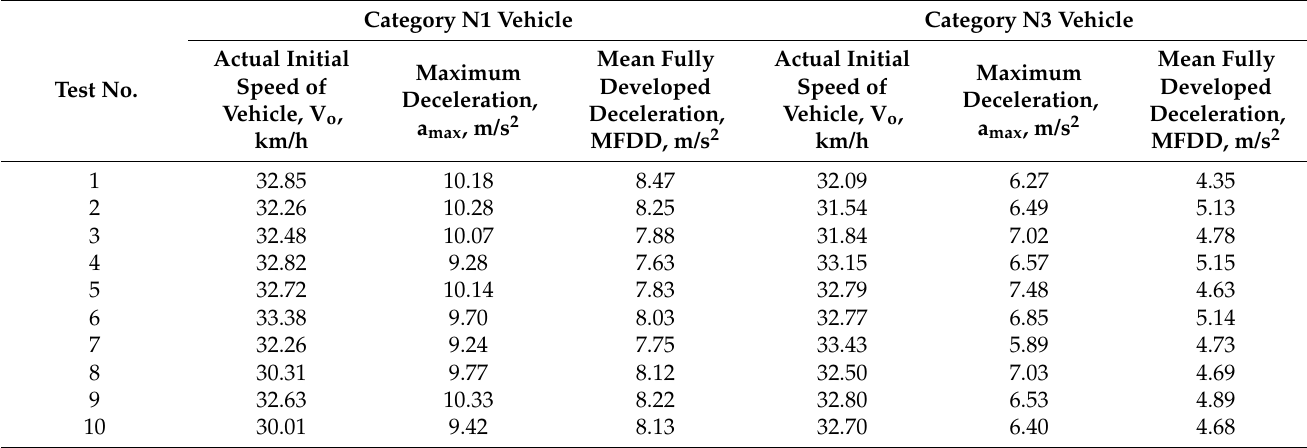
Table 6. Parameters of the braking process on a wet concrete pavement from 30